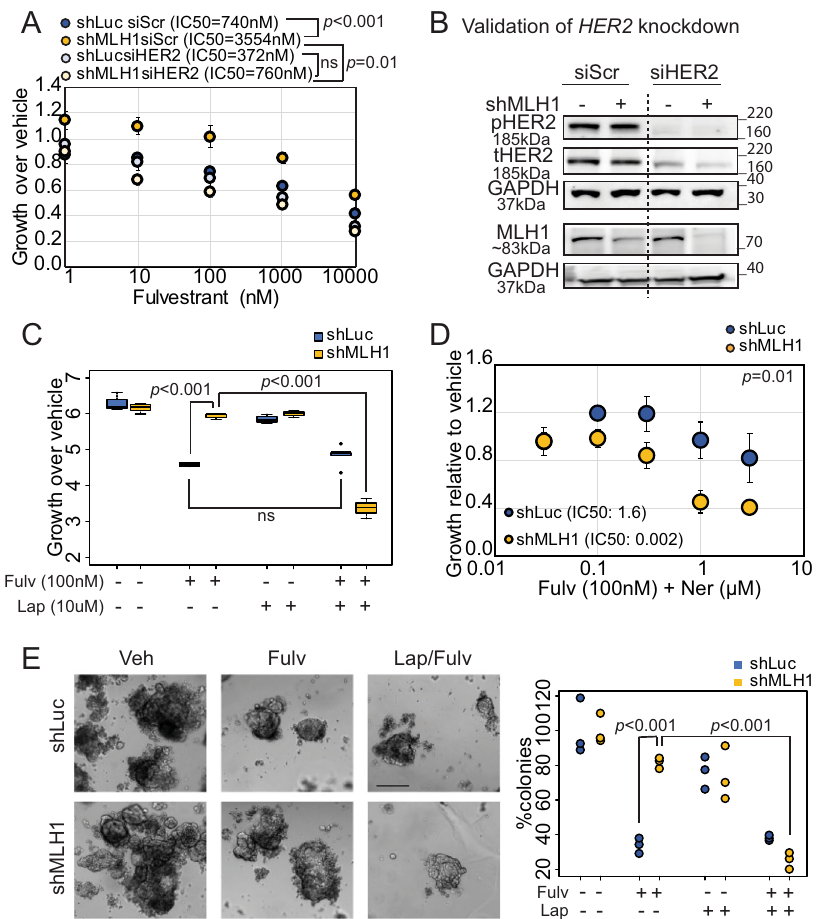
Fig. 4 HER2 is required for endocrine-therapy-resistant growth of ER + MLH1 − breast cancer cells. Knockdown of endogenous HER2 using siRNA against HER2 or a scrambled control in MCF7 sh Luc and sh MLH1 cells validated by Western blotting ( B ) and followed by 2D growth assays for dose response to fulvestrant treatment ( A ). For sh Luc vs. sh MLH1 with siScr, p = 0.0001. Supporting data demonstrating similar response to tamoxifen and estrogen deprivation in Fig. S5A, B. C Growth of MCF7 sh Luc and sh MLH1 cells in response to speci fi ed therapeutic combinations represented as a bar graph. For sh Luc vs. sh MLH1 with fulvestrant treatment, p = 0.0009, and for sh MLH1 fulvestrant vs. lapatinib + fulvestrant treatment, p = 3.15e − 05. Supporting data